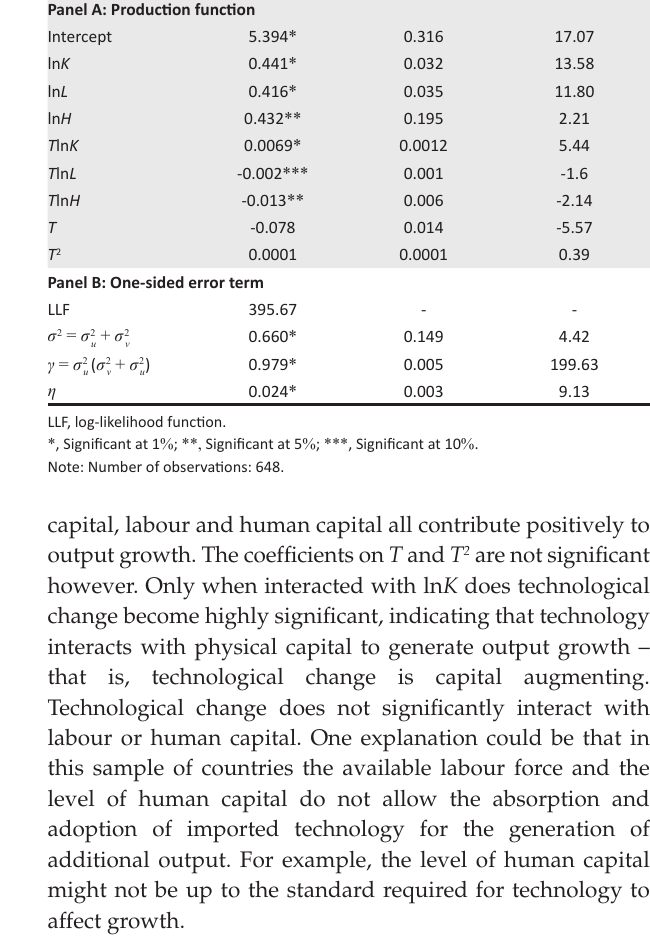
TABLE 4: Technical efficiency ranking. Country Technical efficiency